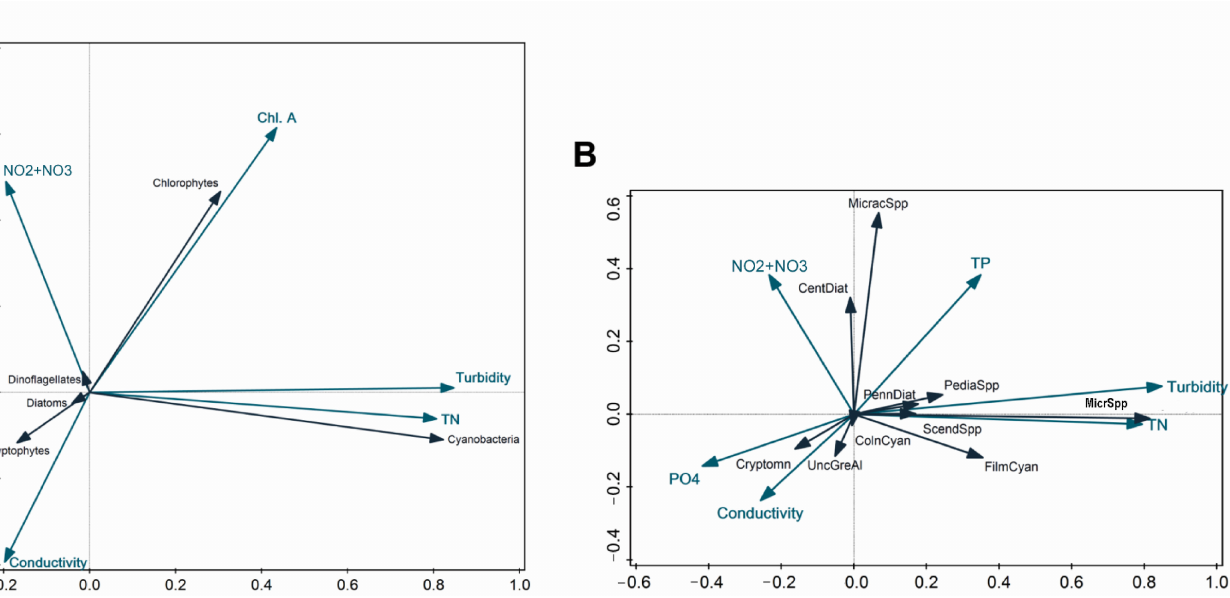
Figure 10. RDA plots for phytoplankton biomass for the whole study period. ( A ) phytoplank- ton presented as classes; ( B ) phytoplankton presented as groups. Blue arrows—environmental parameters; black arrows—phytoplankton taxa: MicracSpp— Micractinium spp., PennDiat—pennate diatoms, PediaSpp— Pediastrum spp., MicrSpp— Microcystis spp., ScendSpp— Scenedesmus spp., FilmCyan—filamentous cyanobacteria, ColnCyan—colonial cyanobacteria, UncGreAl—unicellular green algae, Cryptomn—cryptomonads. Only significant environmental factors ( p < 0.05) are dis- played. Graphical relationships between different parameters reflect the contribution percentage of each parameter accounting for simple effects, which vary from the percentage contribution based on the conditional effects, used for results